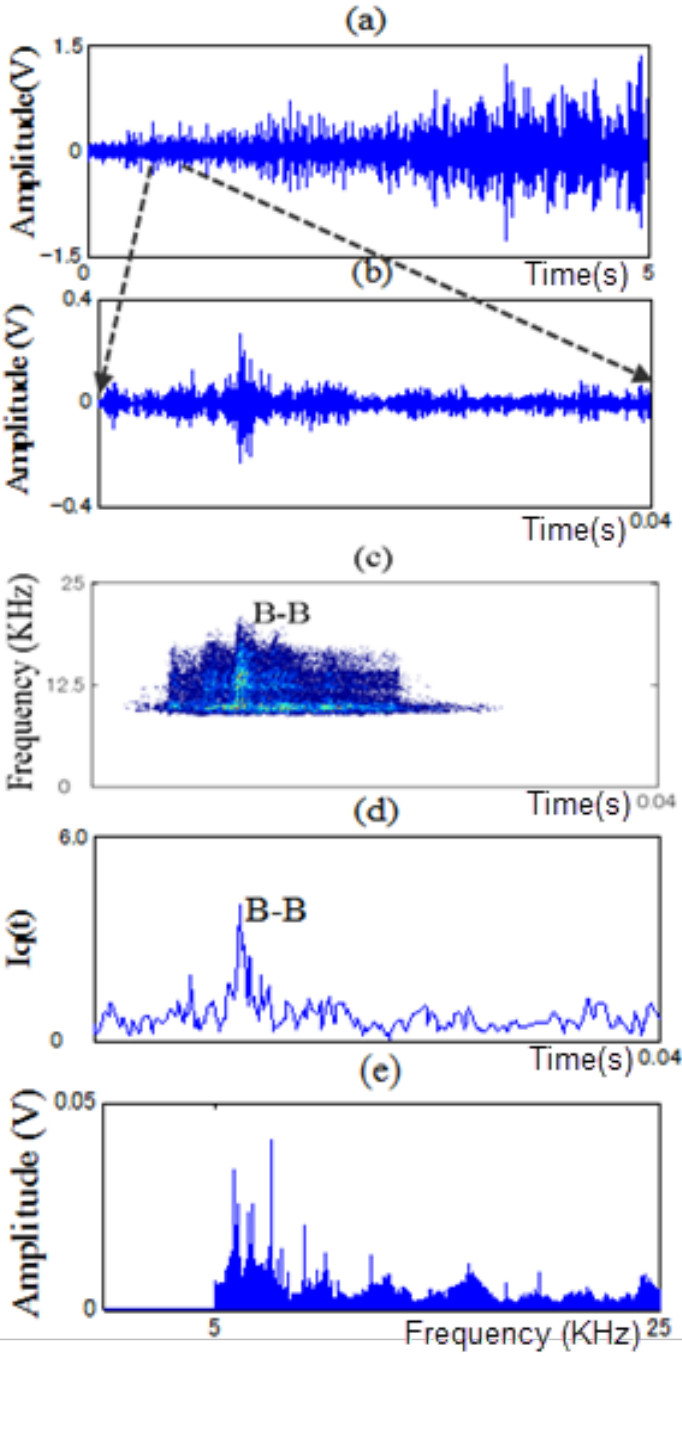
Figure 13. Contour graph and RCI of the spectra in the inner-race defect state: ( a ) time signal. ( b ) a part of time signal. ( c ) contour graph. ( d ) RCI and ( e ) power spectrum at position